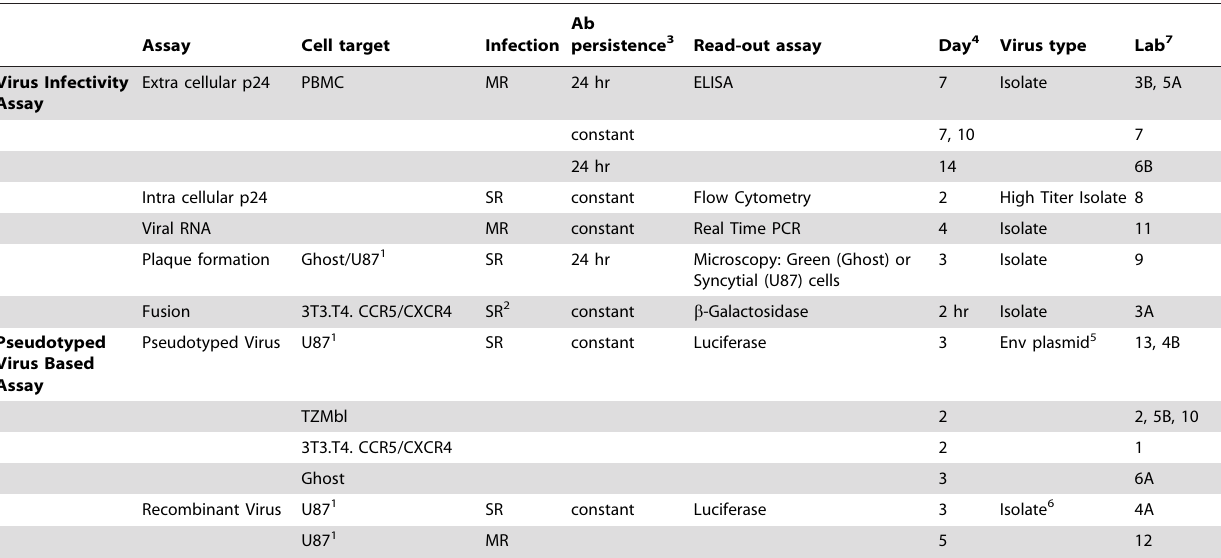
Table 1. Neutralization assays and their